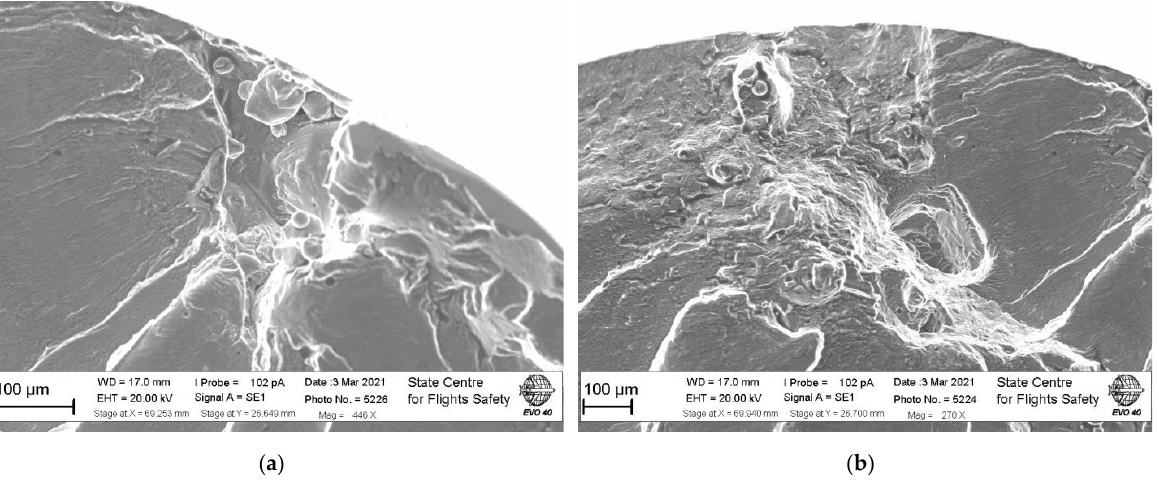
Figure 13. The fracture surface of SLM specimen with multiple crack initiations. The fracture surface of SLM specimen with multiple crack initiations ( a ) and semi-ellipsoid crack starting from the boundary of layers ( b ).